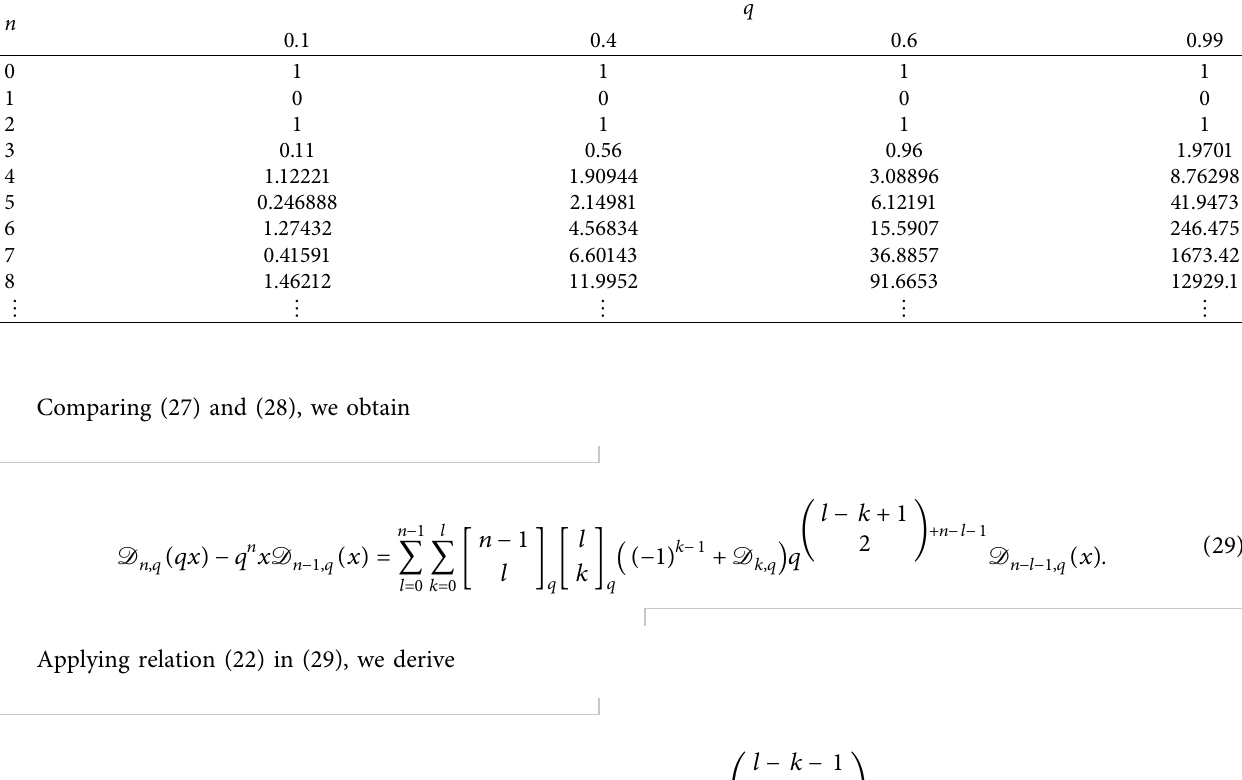
Table 2: Approximate values of D